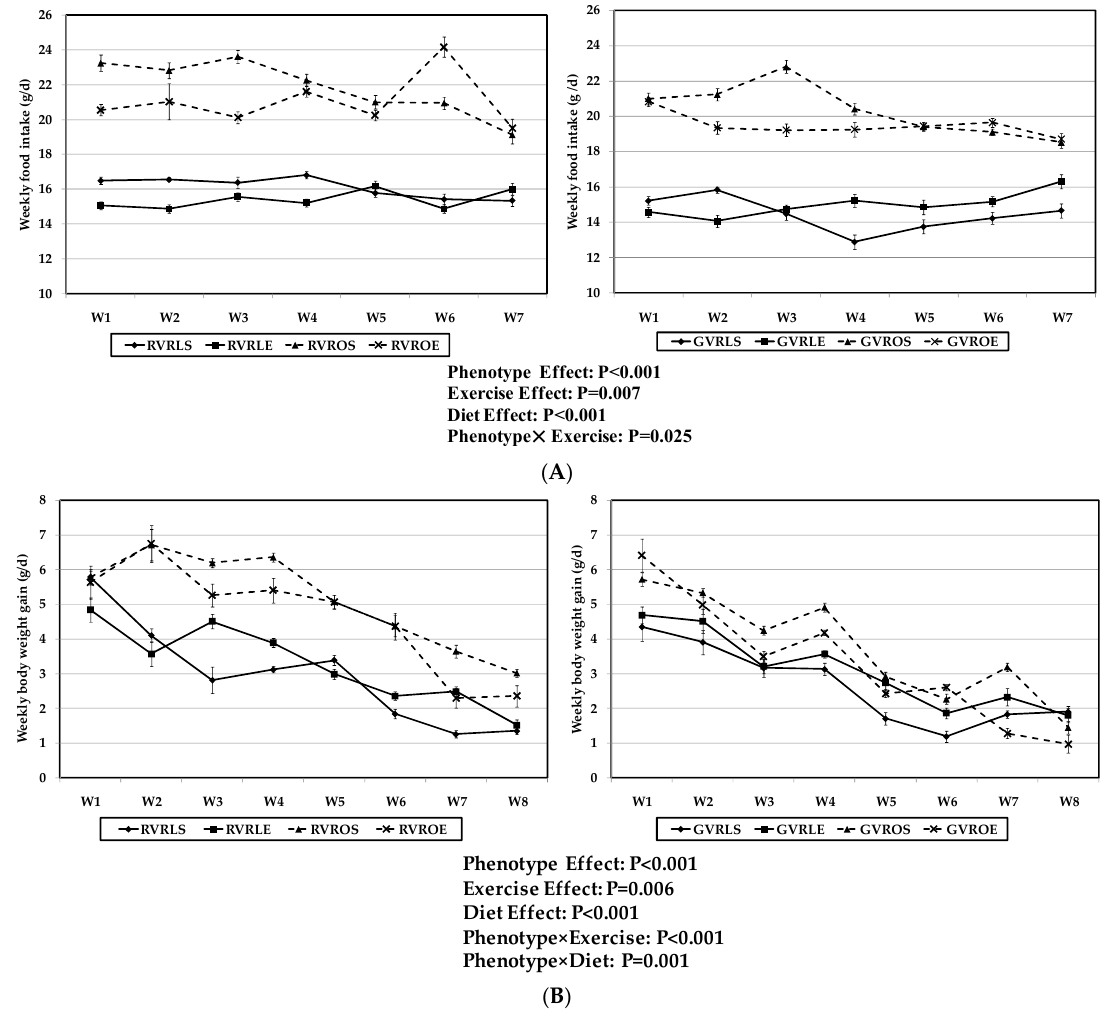
Figure 3. Effect of dietary treatment with raw or 4 day-germinated V. radiata and aerobic interval training protocol on food intake ( A ) and body weight gain ( B ) of lean and obese Zucker rats. ( A ) Weekly food intake (g DM/day); ( B ) Weekly body weight gain (g/day). DM, dry matter, RVR, raw V. radiata , GVR, 4 day-germinated V. radiata . Groups: LS, Lean ( fa /+) sedentary rats, LE, Lean ( fa /+) rats performing aerobic interval exercise, OS, Obese ( fa / fa ) sedentary rats, OE, Obese ( fa / fa ) rats performing aerobic interval exercise. W, week. Values are means ± SEM depicted by vertical bars ( n = 10).